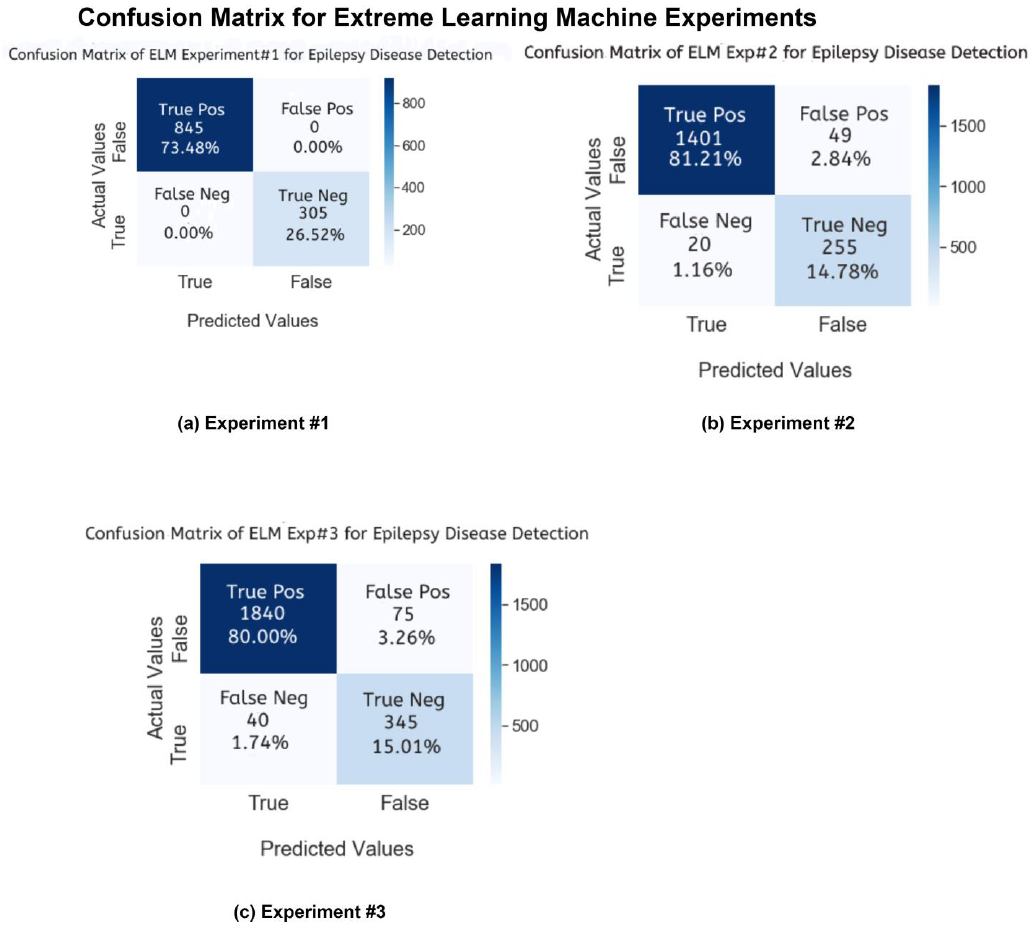
Figure 9. Confusion Matrices of ( a ) Experiment #1; ( b ) Experiment #2; ( c ) Experiment